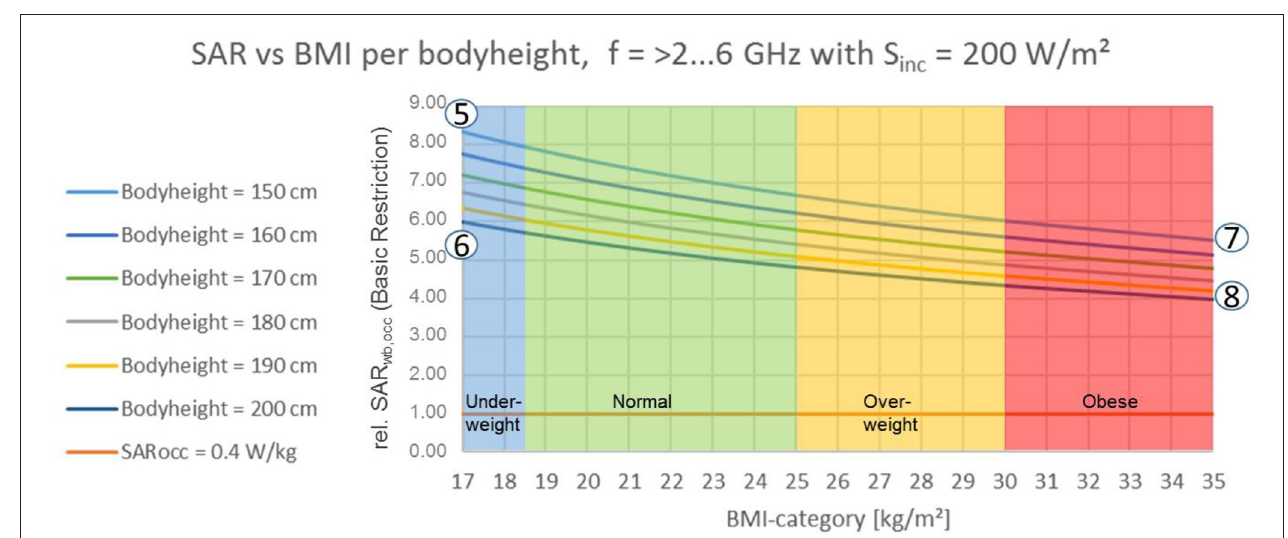
FIGURE 4 | Unintended exposure of whole-body at local exposure levels, e.g., due to accident (with Body Surface Exposure Ratio c pwbs . on Specific Absorption Rate in relation to Body-Mass-Index Category for frequencies > 2–6 GHz, T avg .